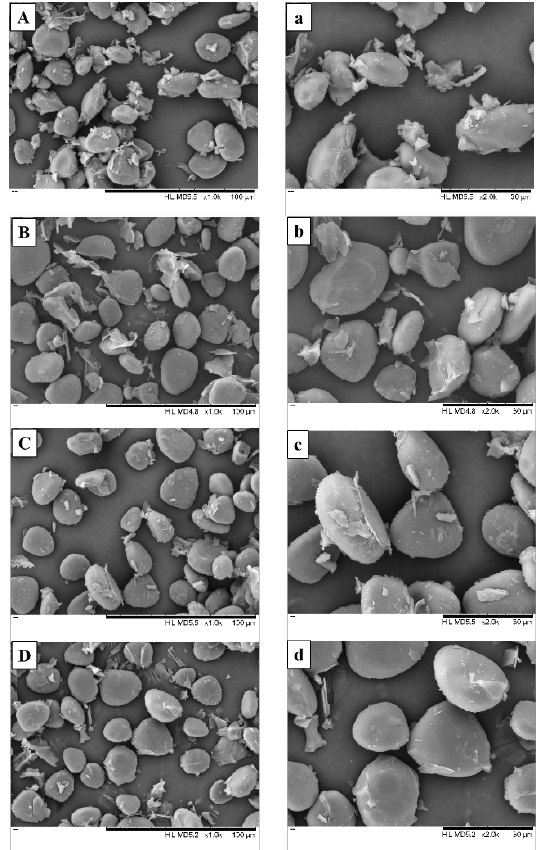
Figure 4. Scanning electron microscopy of yam flours at a magnification of 1000× ( A – D ) and 2000× ( a – d ). ( A , a ) HAD samples; ( B , b ) MFD 0.5 W/g samples; ( C , c ) MFD 1.0 W/g samples; ( D , d ) MFD 1.5 W/g samples.